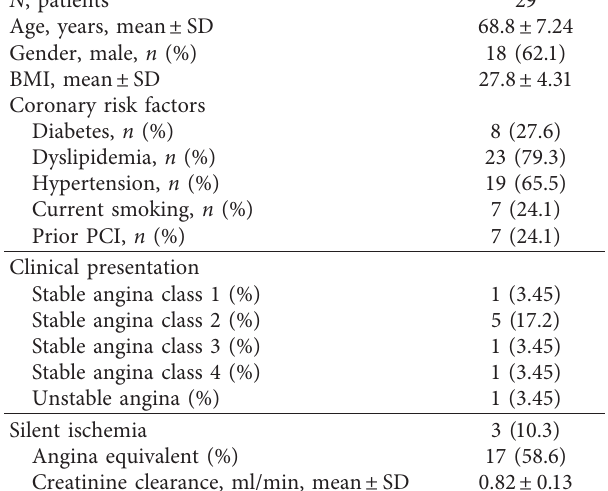
Table 1: Clinical and angiographic characteristics. N ,